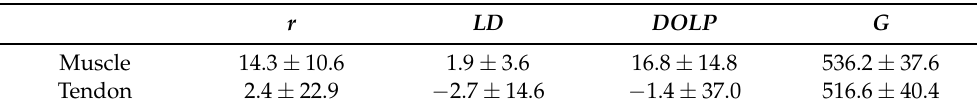
Table 1. Statistical estimation of the averages and the standard deviations of the four polarimetric parameters for each scattering angles from Figure 7. The values correspond to the integrated spectra per scattering angle. r , LD , DOLP , and G are the anisotropy ratio, linear dichroism, degree of linear polarization, and grating factor,